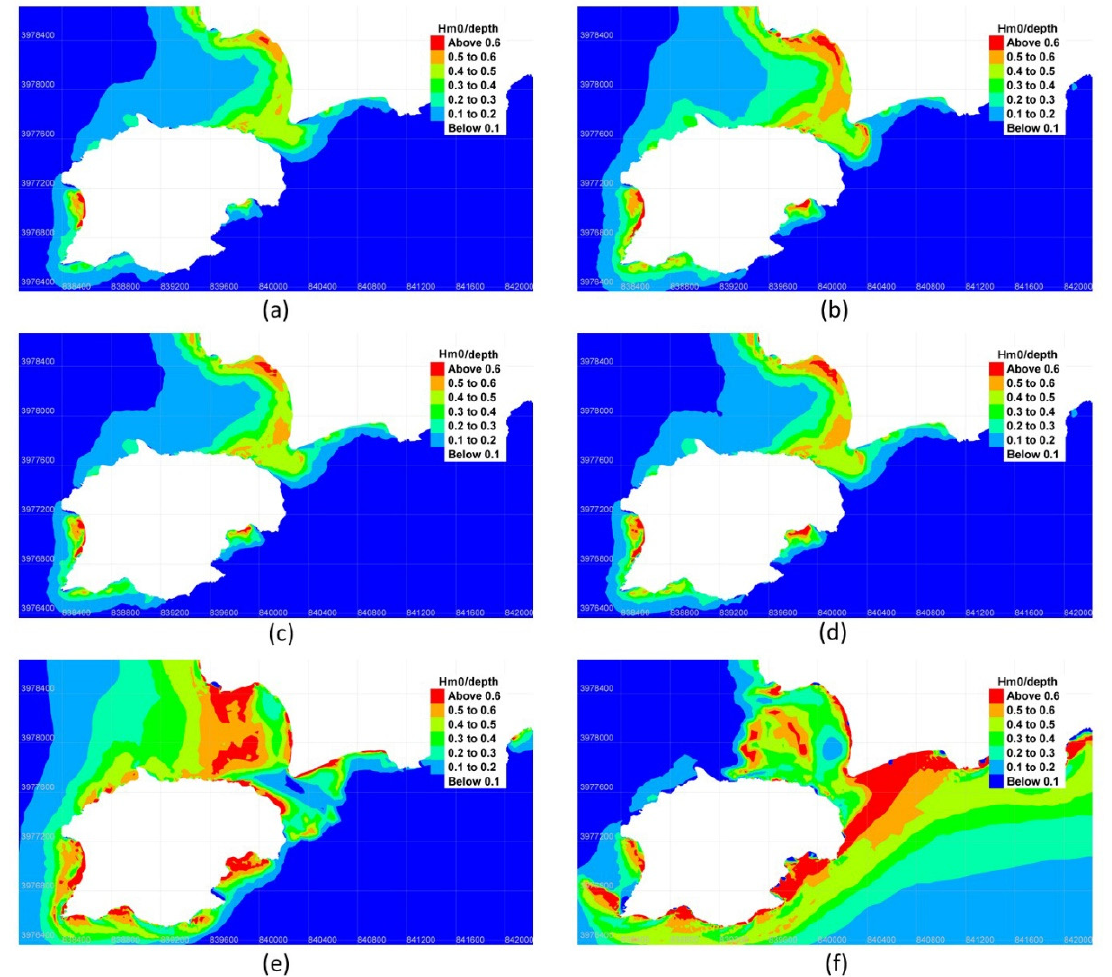
Figure 19. Maps of the approximate surf zone index, i.e., Hm0/depth, in the sea area of interest for wave scenario 1 ( a ), 2 ( b ), 3 ( c ), 4 ( d ), 5 ( e ), and 6 ( f ). Maps created in Blue Kenue™ software tool for hydraulic modellers.